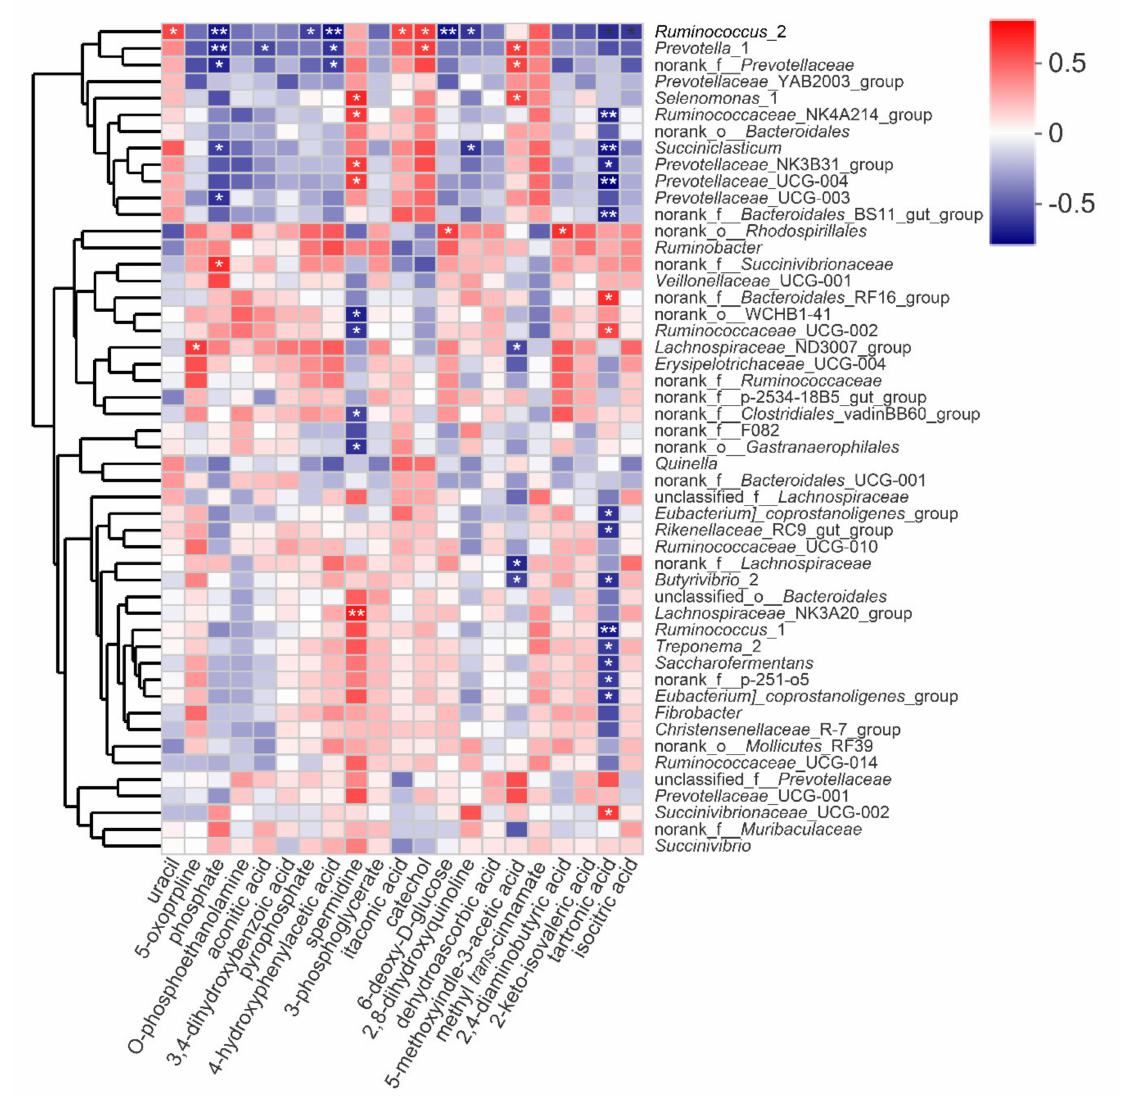
Figure 6. Correlation between bacterial genera and deferential metabolites a ff ected by diets with di ff erent energy and protein levels. Correlations are indicated by red and blue colors; 1 indicates a perfectly positive correlation (dark red) and close to − 1 indicates a perfectly negative correlation (dark blue). Weak correlation is indicated by white colors. * and ** indicate p < 0.05 and p ≤ 0.01,